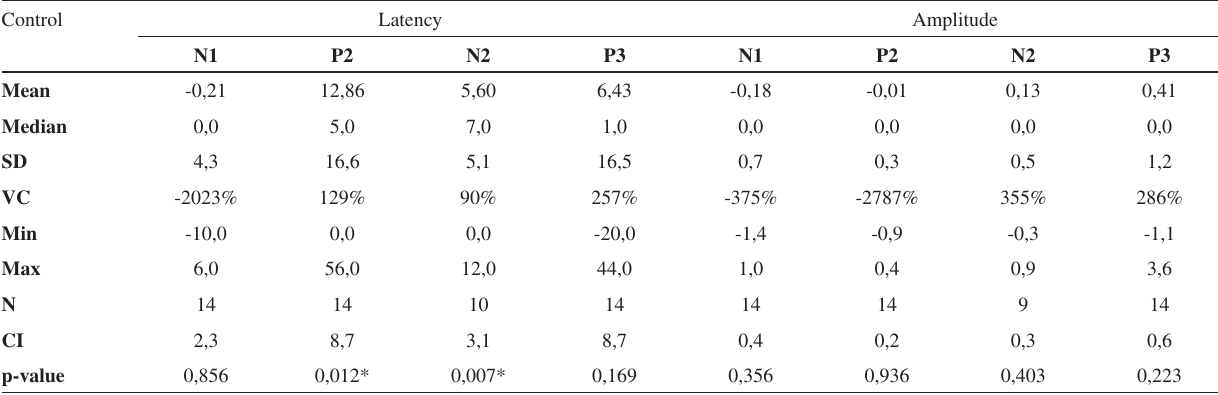
Table 4 - Variations in latency and amplitude values of LLAEP for the control group when comparing pre- and post-training evaluations